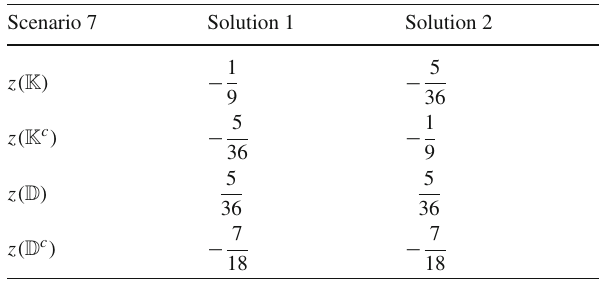
Table25 Valuesofthe U ( 1 ) (cid:2) chargesfortheexoticquarksinU μν SSM models using solution (30) with the hypercharges of Case 1 of Table 10. The U ( 1 ) (cid:2) charges of the rest of the fields are given in Table 2 and Scenario 5 of Table 9. The minimal number of singlets under the SM gauge group consistent with these charges is n ν c = 2 Scenario 5